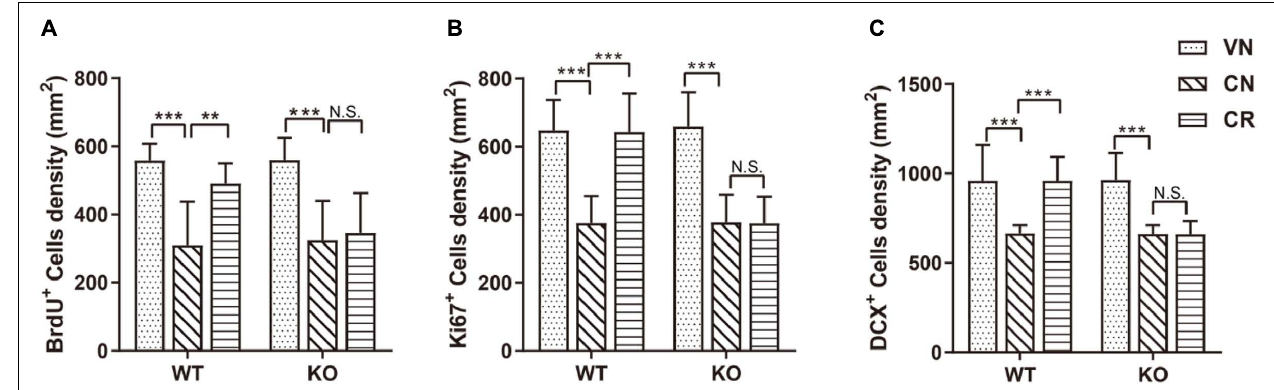
FIGURE 2 | Adiponectin deficiency attenuates exercise-enhanced neurogenesis under stress. (A–C) COR treatment significantly lowered the number of BrdU + newborn cells ( A ; n = 11–12 mice/group), Ki67 + proliferating cells ( B ; n = 9–15 mice/group) and DCX + immature neurons ( C ; n = 9–15 mice/group) in both WT and ADN-KO mice. Voluntary exercise enhanced hippocampal neurogenesis by increasing all these three subsets of cells in COR-treated WT (WCR), but not ADN-null mice (KCR). Data are shown as means ± SD. ** p < 0.01, *** p < 0.001 by two-way ANOVA and Tukey’s post hoc test. N.S., non-significant; BrdU, bromodeoxyuridine; Ki67, cell proliferation-associated nuclear antigen; DCX,